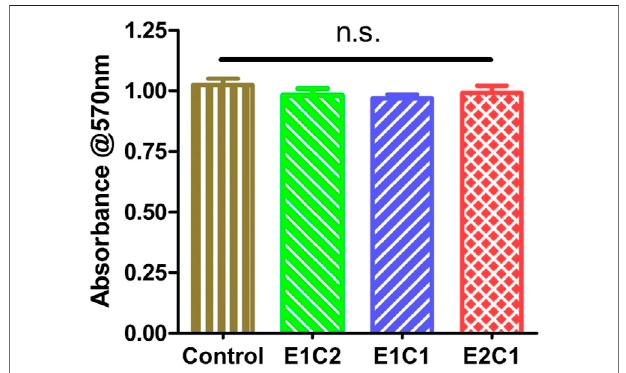
FIGURE 9 | The absorbance of the supernatant at 570 nm of the scaffolds. n.s.: p > 0.05.